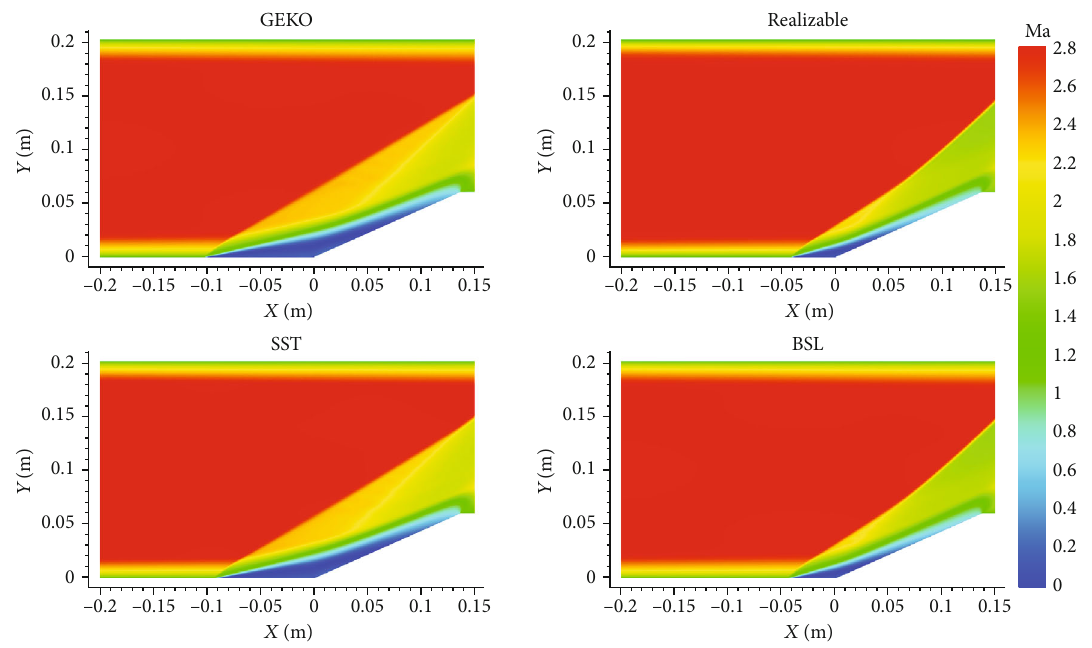
Figure 11: Mach contours over the 24-deg compression